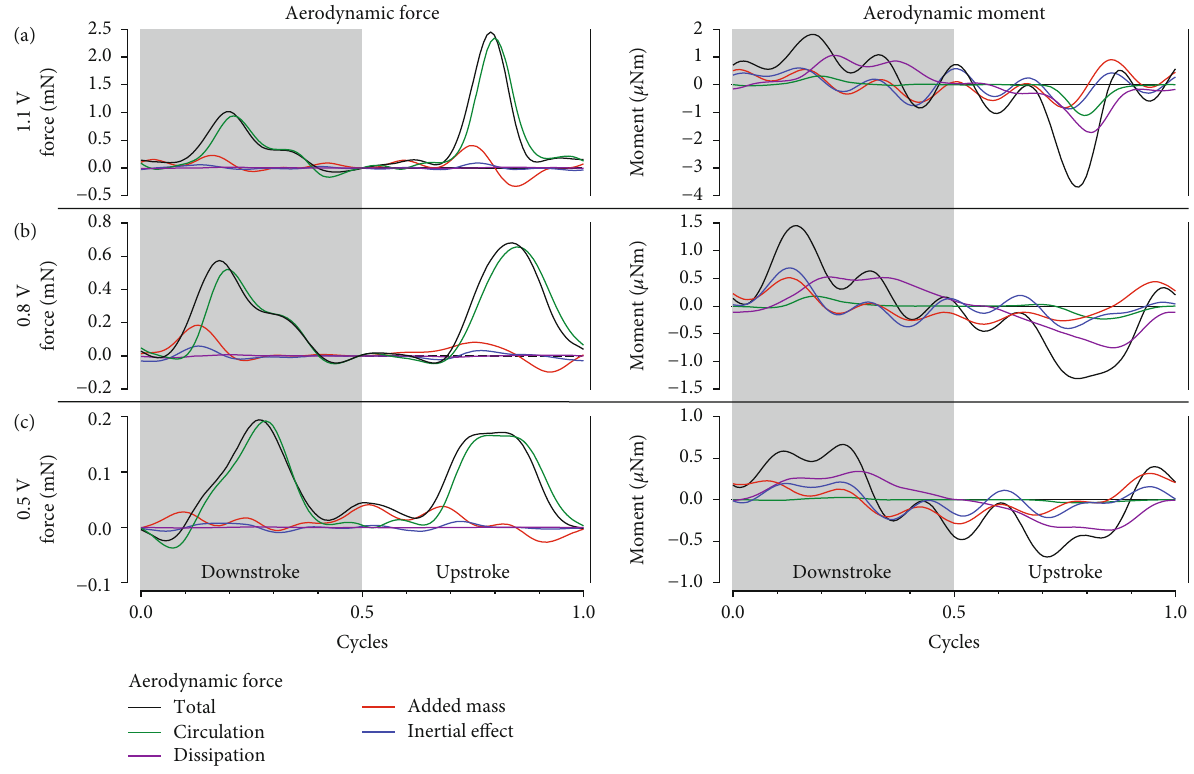
-axis w M under the input voltage amplitudes of (a) Aero, x w